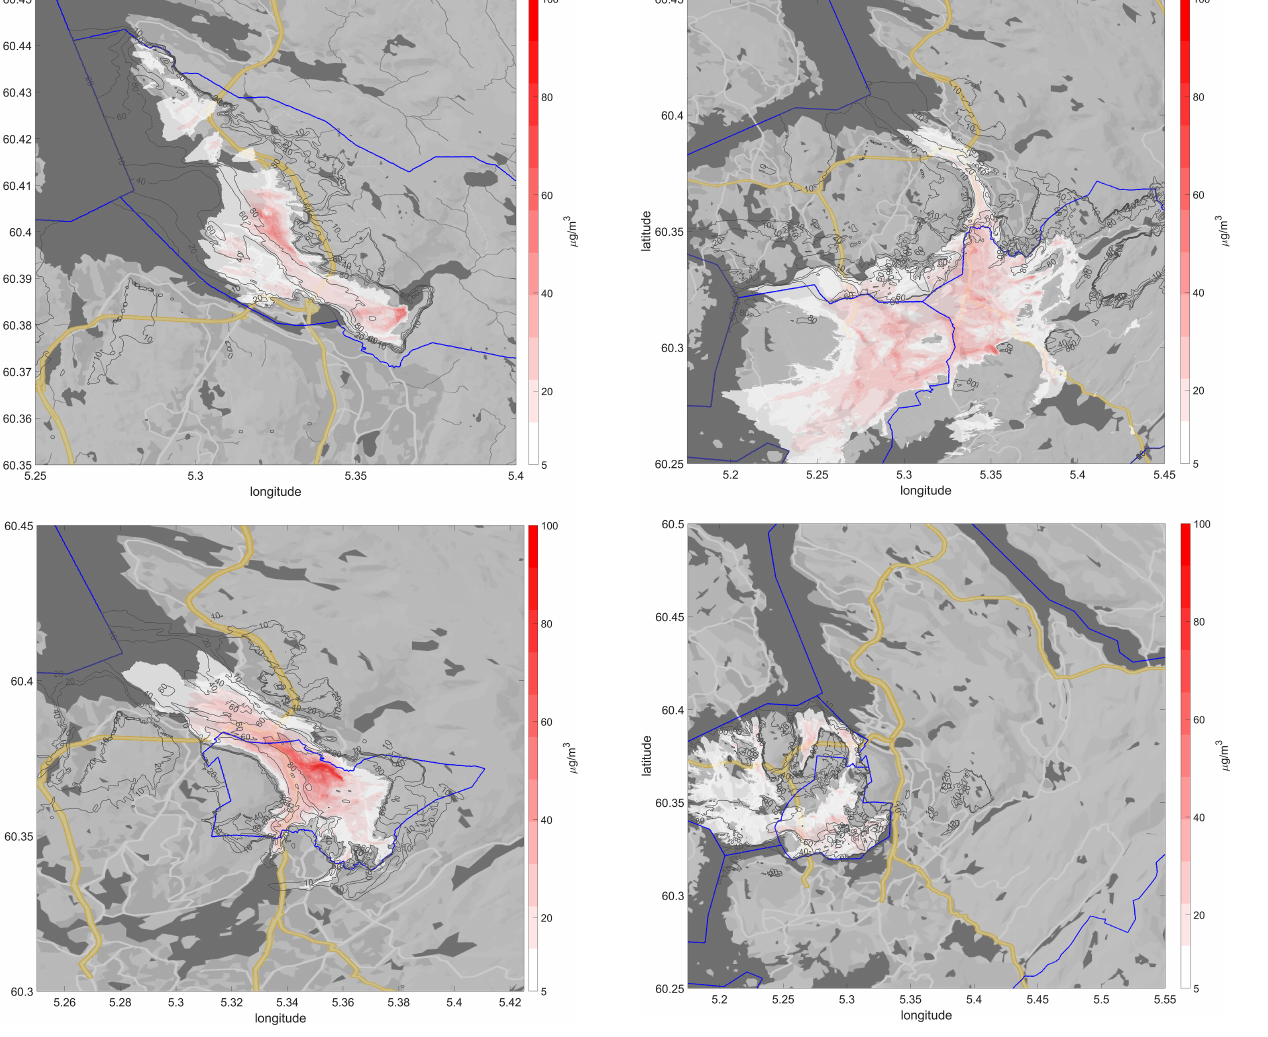
Figure 4. The simulated surface-layer concentrations of PM 2 . 5 for scenario 1 (shown in Fig. 3, top panel) but for emissions only from stoves within the Bergenhus (top) and Årstad (bottom) districts. The simulations use the current distributions of the number and types of stoves. The blue lines show the district boundaries. Thin grey isolines indicate the fraction of the total pollution that was caused by the emissions within the respective district. Data overlay the grayscale map from © Google Maps 2019.